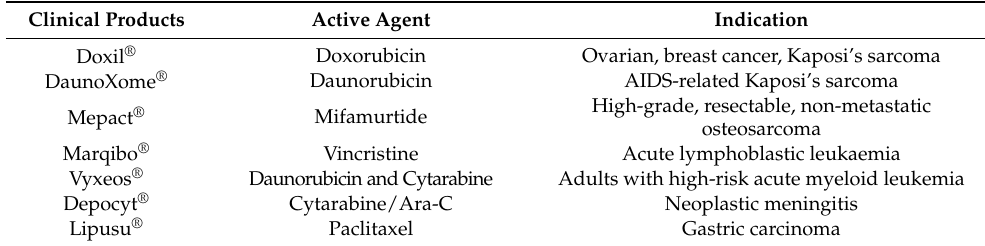
Table 4. Clinically used liposomes and their